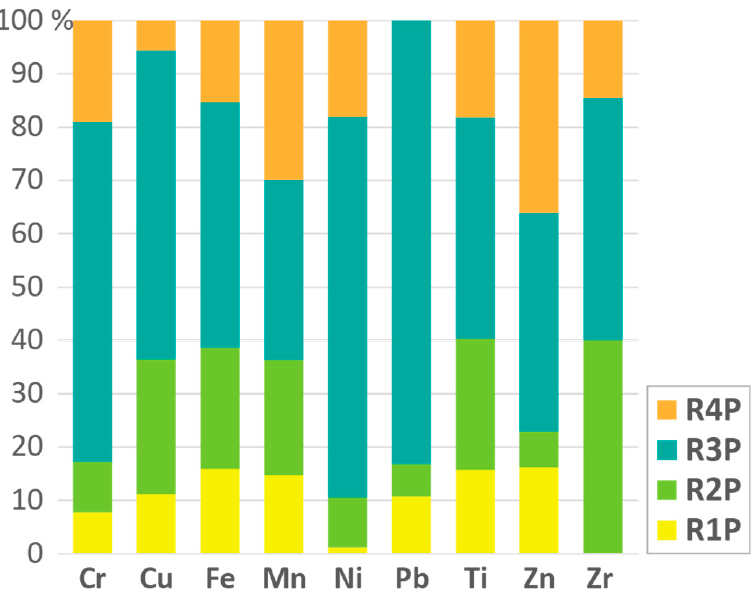
Figure 5. Transfer factor (TF) from soil to plants (relative quantification, in %). Daily elemental intake (DIM) and hazard risk index (HRI) are presented in Table